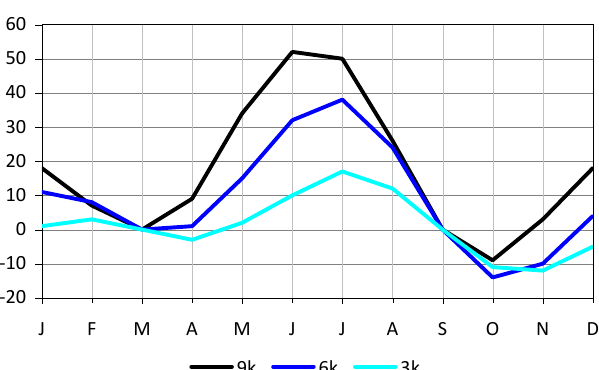
Figure 12. Solar incoming radiation at 50 ◦ N, 30 ◦ N and insolation gradient between 30 ◦ N and 30 ◦ S for different time-slices (9, 6